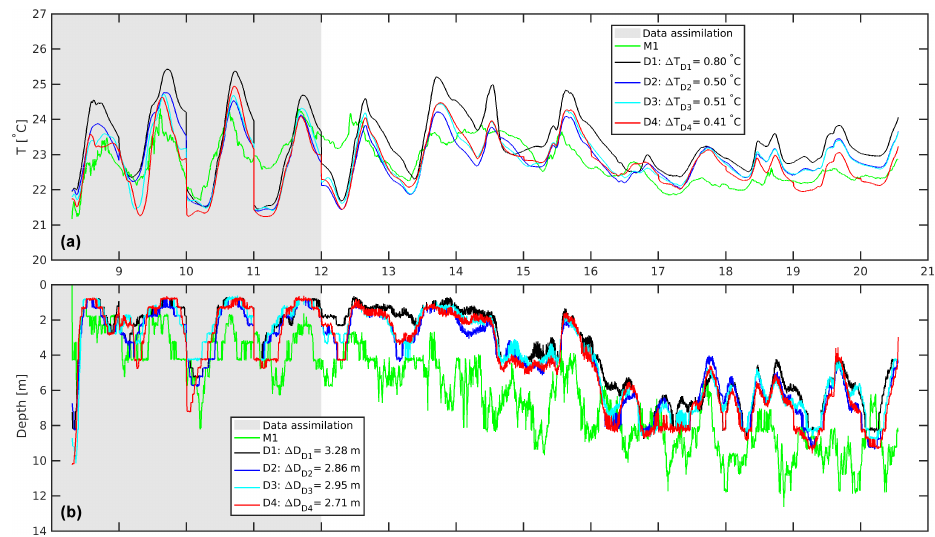
Figure 17. ROMS runs D1–D4: the time series of (a) the near-surface temperature at 0.81m of depth, (b) the mixed-layer depth (MLD), and the corresponding observations at mooring M1. The numbers on the abscissae indicate June dates. The period for which the data are assimilated is highlighted with grey shading.